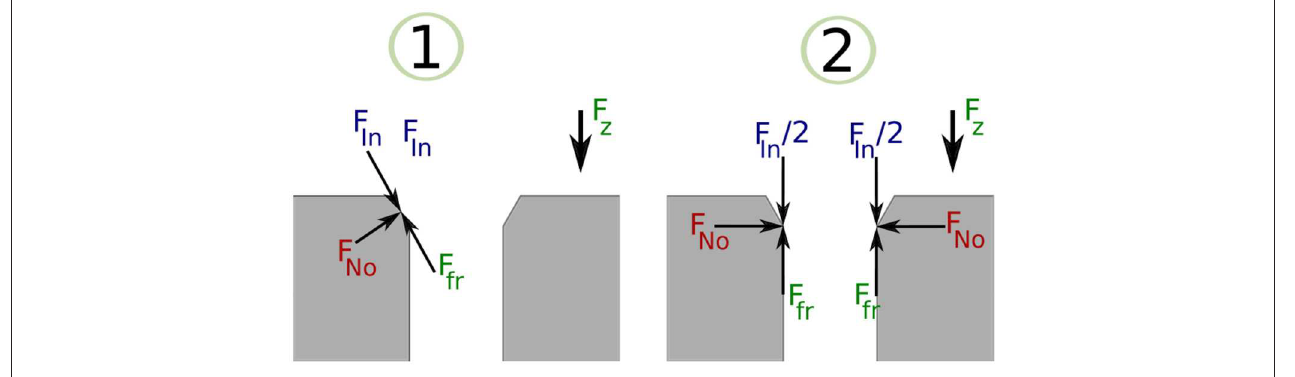
FIGURE 5 | Chamfer-Crossing PiH stage: force analysis.